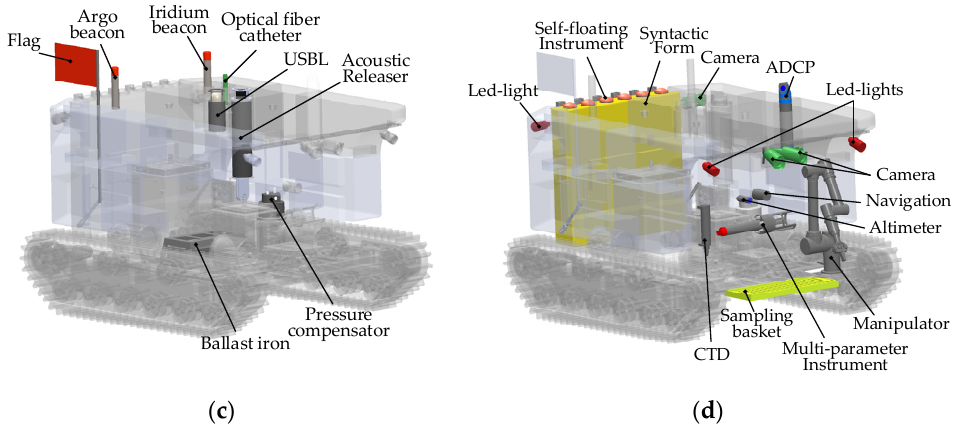
Figure 3. Four major subsystems: ( a ) Chassis drive and crawling systems; ( b ) energy and electronic systems; ( c ) location and recovery systems; ( d ) instrument payload and communication systems.